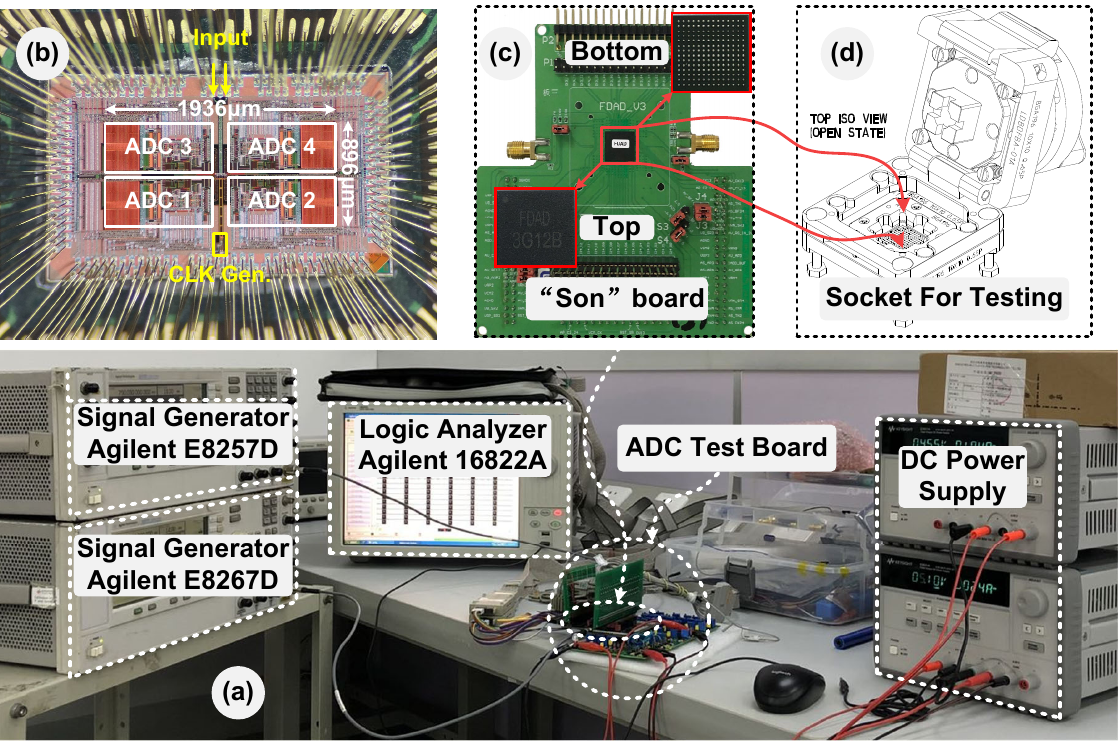
Figure 10. Chip microphotograph and measurement details: ( a ) The measurement setup for the 4-way TI-ADC; ( b ) Chip microphotograph; ( c ) The “son” board and associated BGA package; ( d ) The socket for the BGA